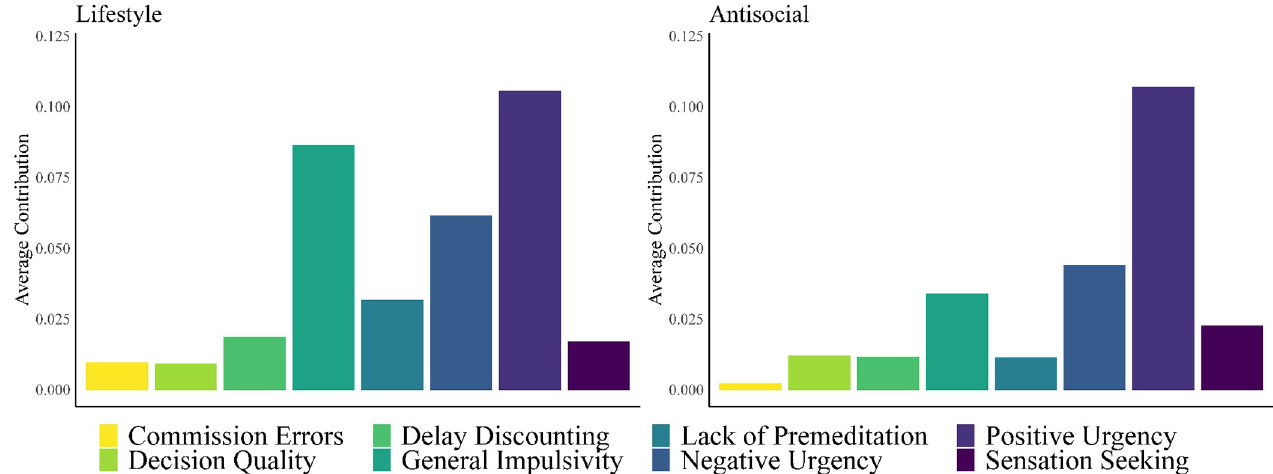
Fig 2. General dominance plots of the average contribution (via R 2 ) of each predictor of the lifestyle (left) and antisocial (right) facets of